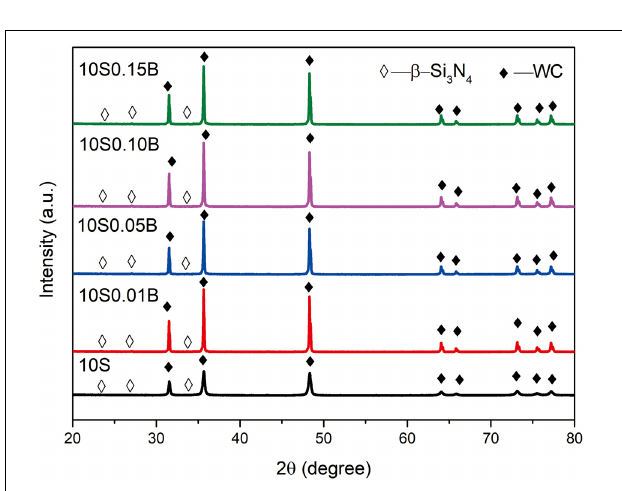
FIGURE 2 | XRD patterns of the composite specimens.